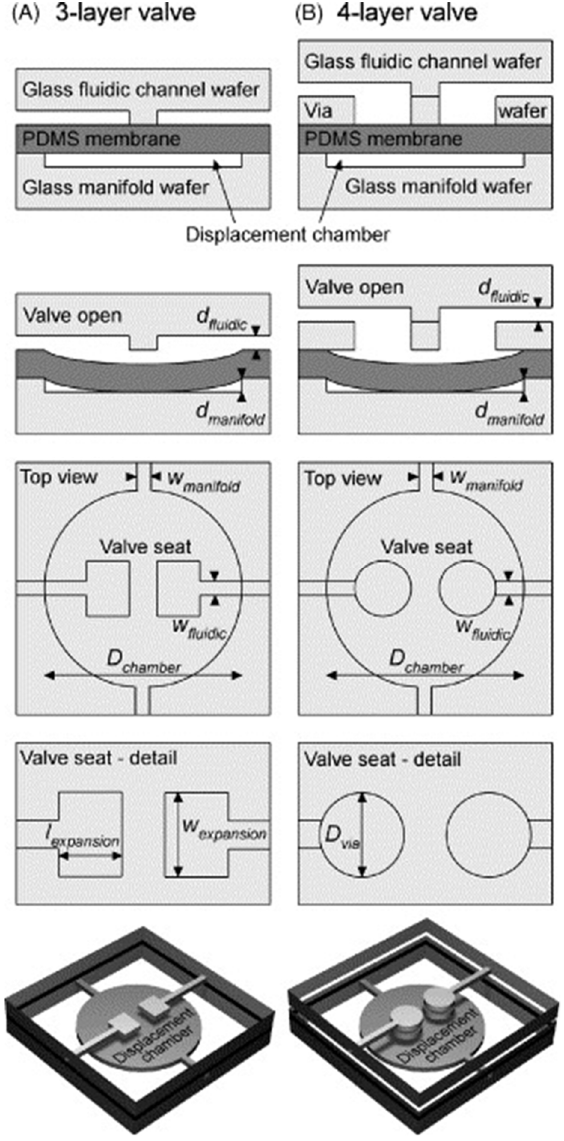
Figure 13. Cross ‐ sectional, top, and oblique views of three ‐ layer ( A ) and four ‐ layer ( B ) monolithic PDMS membrane valves. Each valve consists of a glass manifold with an etched displacement chamber for pneumatic actuation, a working PDMS membrane, and a glass fluidic channel wafer containing the channel to be valved. In the three ‐ layer topology, PDMS defines one surface of the valved channel. In the four ‐ layer structure, the addition of the drilled via wafer defines all ‐ glass fluidic channels with minimal fluid ‐ PMDS contact. Permission granted by the publisher [48].